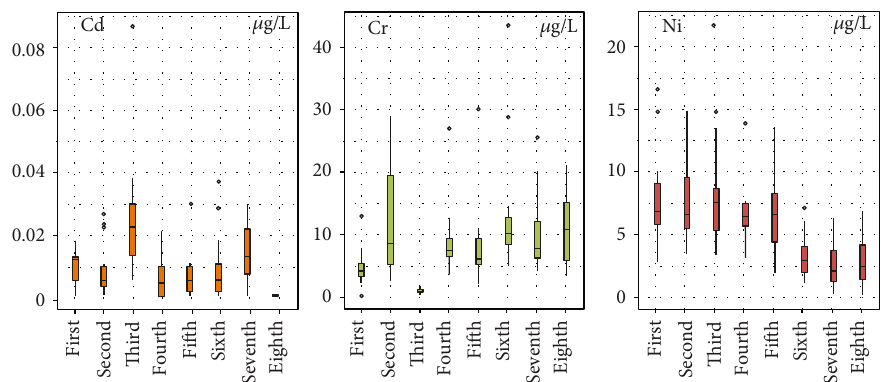
Figure 2: Spatial and temporal variations of Cd, Cr, and Ni in the shallow